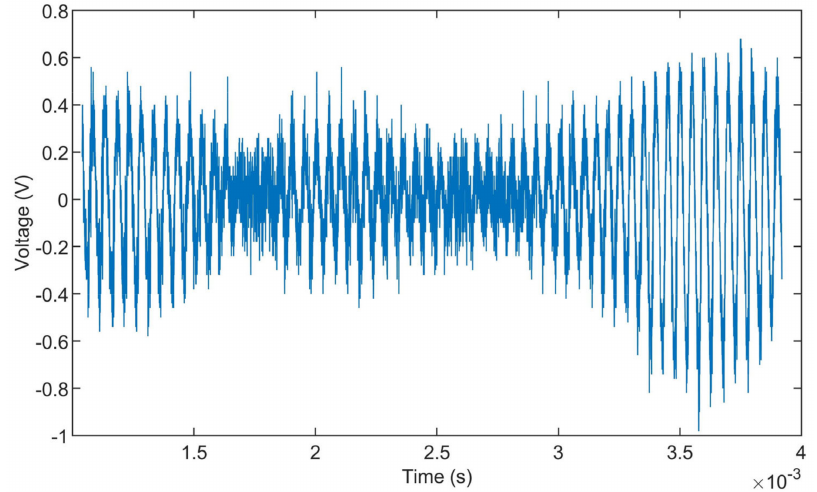
Figure 12. Typical SMI-signal for rotational speed measurement (Reprinted with permission from [18] © The Optical Society).